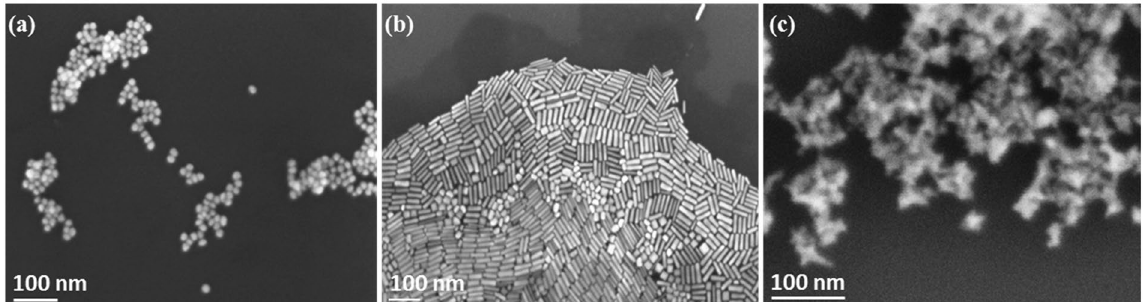
Figure 2. SEM images of ( a ) S - 2 ; ( b ) R - 2 ; ( c ) St - 2 glyco-gold